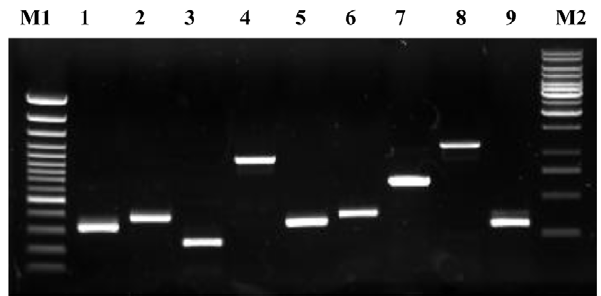
Figure 2. RT-PCR of 9 SpliGV-specific ORFs using mRNAs from S . litura larvae infected with SpliGV as a template. M1, 100-bp DNA ladder (Fermentas, USA); 1, Spli30; 2, Spli40; 3, Spli51; 4, Spli61; 5, Spli63; 6, Spli75; 7, Spli88; 8, Spli121; 9, Spli133; M2, 1-kb DNA ladder (Fermentas, USA).